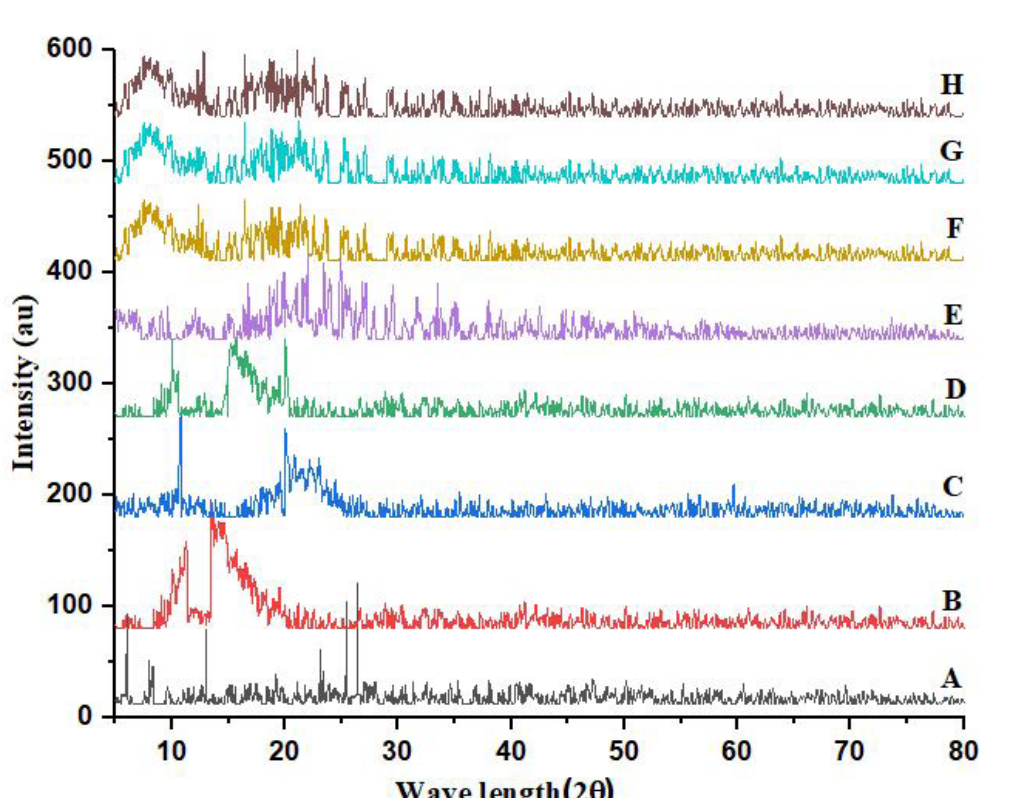
FIGURE 3 - X-ray diffractogram of Metoclopramide (A), Eudragit L100 (B), Polyvinylpyrrolidone K30 (C), Methylcellulose (D), formulations Z4 (E), Z9 (F), Z4-O2 (G) and Z4-E2